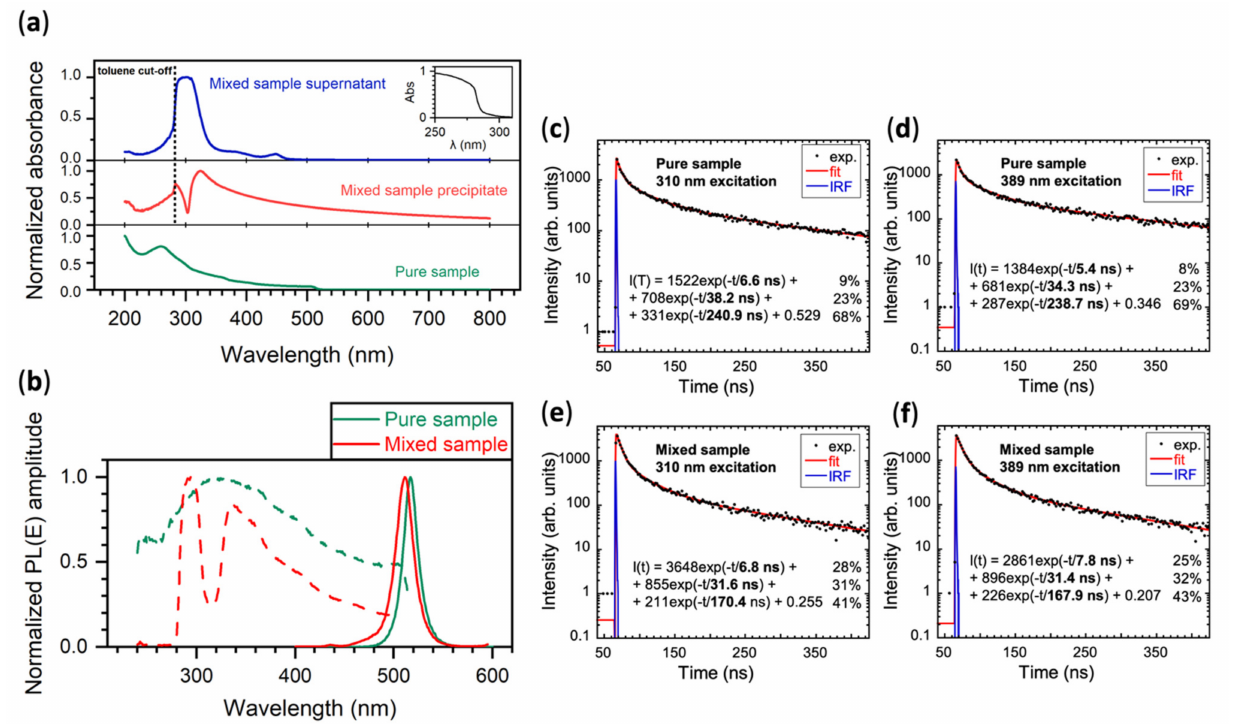
Figure 3. ( a ) Absorption spectra of both the supernatant (blue line) and precipitate (red line) of the mixed sample (in toluene) and that of the pure sample (green line, in hexane), in the inset: absorption spectrum of toluene; ( b ) PL characteristics of the pure sample (green lines) and the mixed sample (red lines), excitation spectra, collected at the emission maxima, are in dashed lines, emission spectra in solid lines, excitation wavelength was 300 nm in both cases; and ( c – f ) PL decay curves of both the pure ( c , d ) and mixed ( e , f ) samples, excited at 310 nm ( c , e ) and 389 nm ( d , f ). Black dots represent the experimental data, red line is the best fit (3-exponential function), and blue line is the instrumental response function